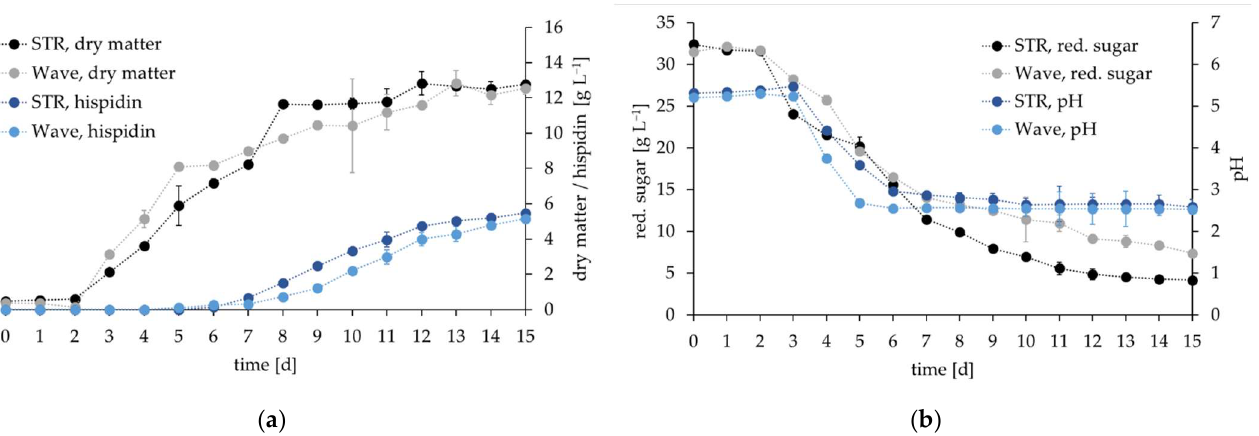
Figure 4. Parallel cultivation of I. hispidus in a stirred tank (STR, depicted in black and dark blue) and cell-bag bioreactor (wave, depicted in gray and light blue). ( a ) Pigment and biomass yield, ( b ) consumption of reducing sugars, and pH over the course of cultivation.